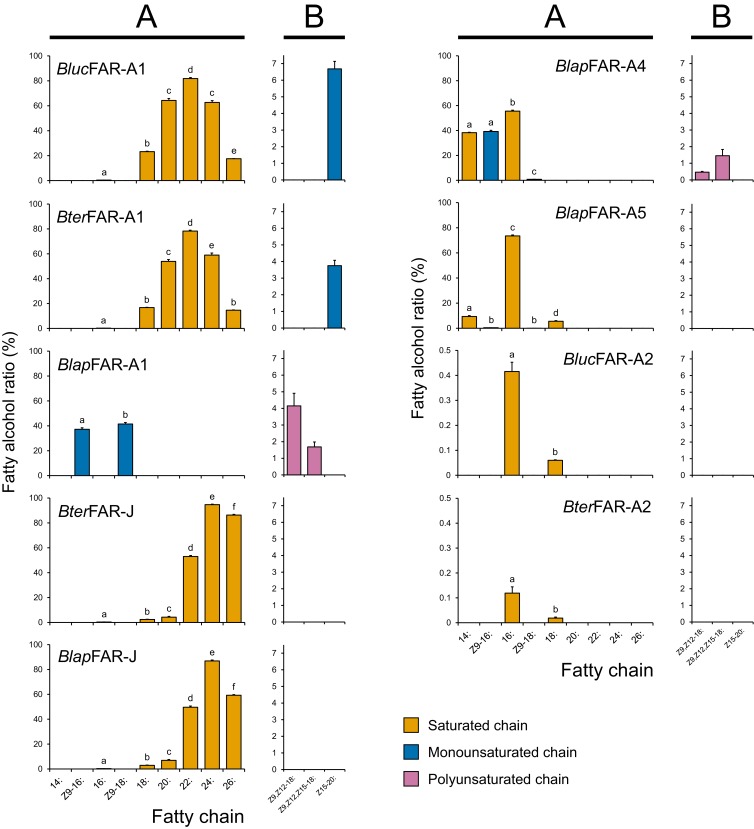
Apparent specificity of bumble bee FARs expressed in yeasts.The fatty alcohol ratios represent the apparent specificity of individual MMP-biosynthetic FAR candidates when expressed in yeast hosts (N = 3). The fatty alcohol production was quantified by GC analysis of yeast total lipid extracts with the recombinant FARs either acting on yeast native lipids (A) or acting on non-native substrates after supplementation of yeasts with either Z9,Z12-18:, Z9,Z12,Z15-18: or Z15-20: acyl-CoA precursors (B). The data in (B) panel of BlucFAR-A1 and BlucFAR-A2 are taken from yeasts expressing the proteins from yeast codon-optimized nucleotide sequences. Note the different y-axis scale for BterFAR-A2 and BlucFAR-A2. Significant differences (p < 0.01, one-way ANOVA followed by post-hoc Tukey’s HSD test) are marked with different letters. See Equation 1 for a description of fatty alcohol ratio calculation.10.7554/eLife.39231.031Figure 6—source data 1.List of fatty alcohol and fatty acyl quantities in FAR-expressing yeasts and fatty alcohol ratios of FARs.The file contains a list of quantified fatty alcohols and fatty acyl methyl esters (transesterifiable fatty acyls) in yeasts which express bumble bee FARs and of fatty alcohol ratio values for individual FARs and the results of statistical testing.